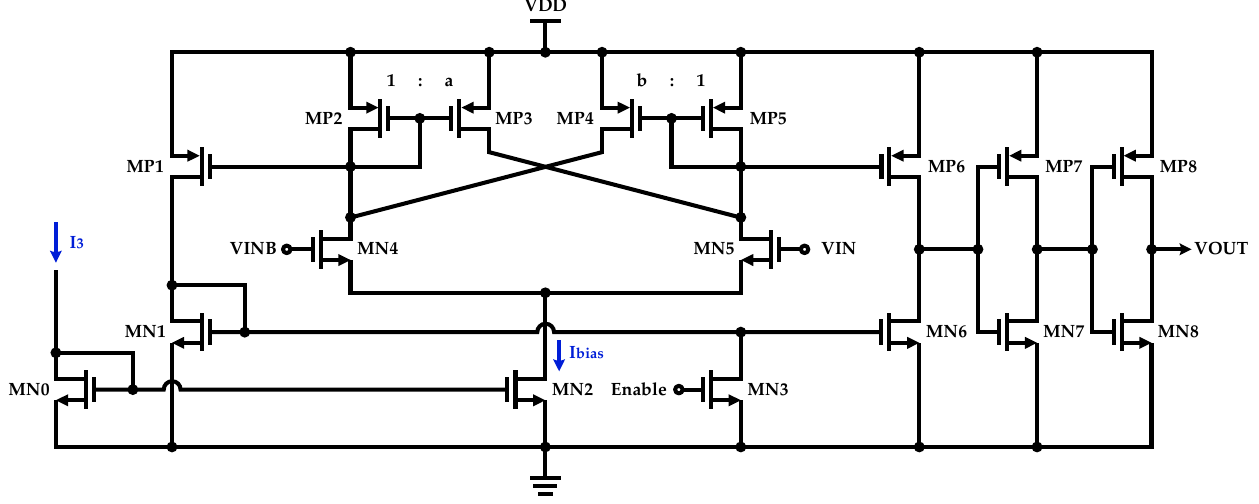
Figure 5. Structure of the implemented non-inverting hysteresis comparator.